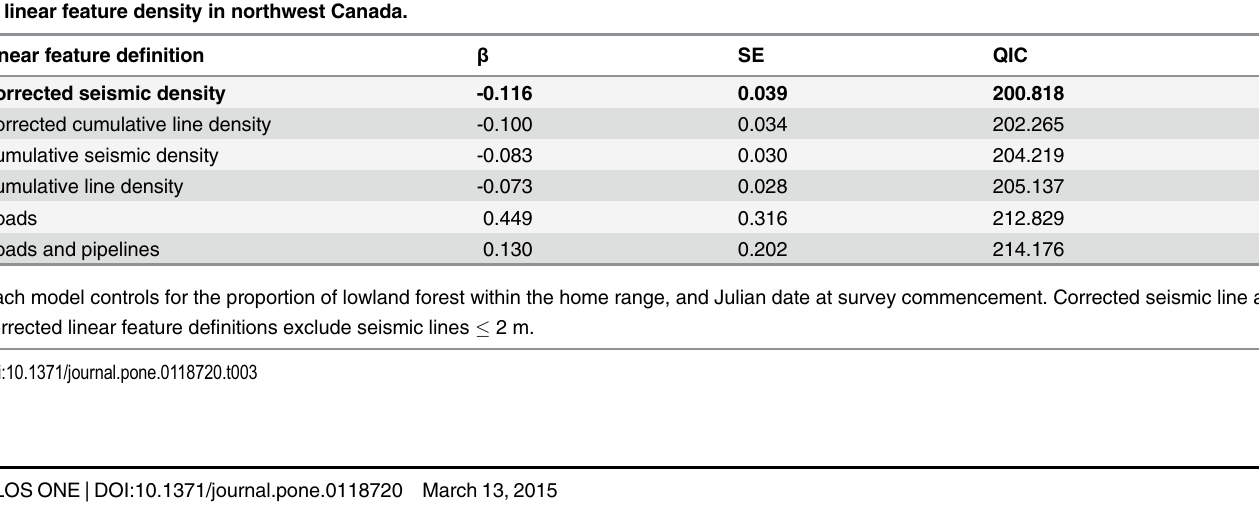
Table 3. Final models comparing predicted home range occurrence of the American marten ( Martes americana ) relative to different de fi nitions of linear feature density in northwest Canada. Linear feature de fi nition